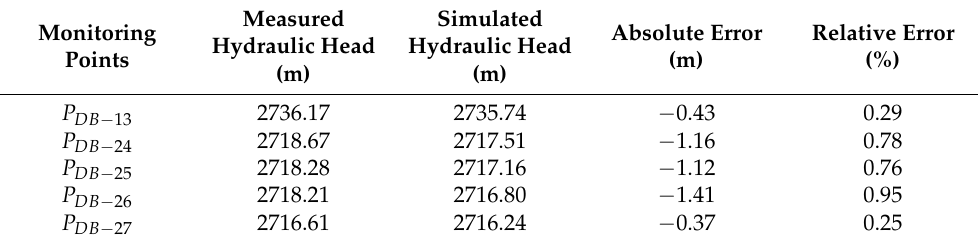
Table 5. Comparison between the calculated and measured hydraulic head